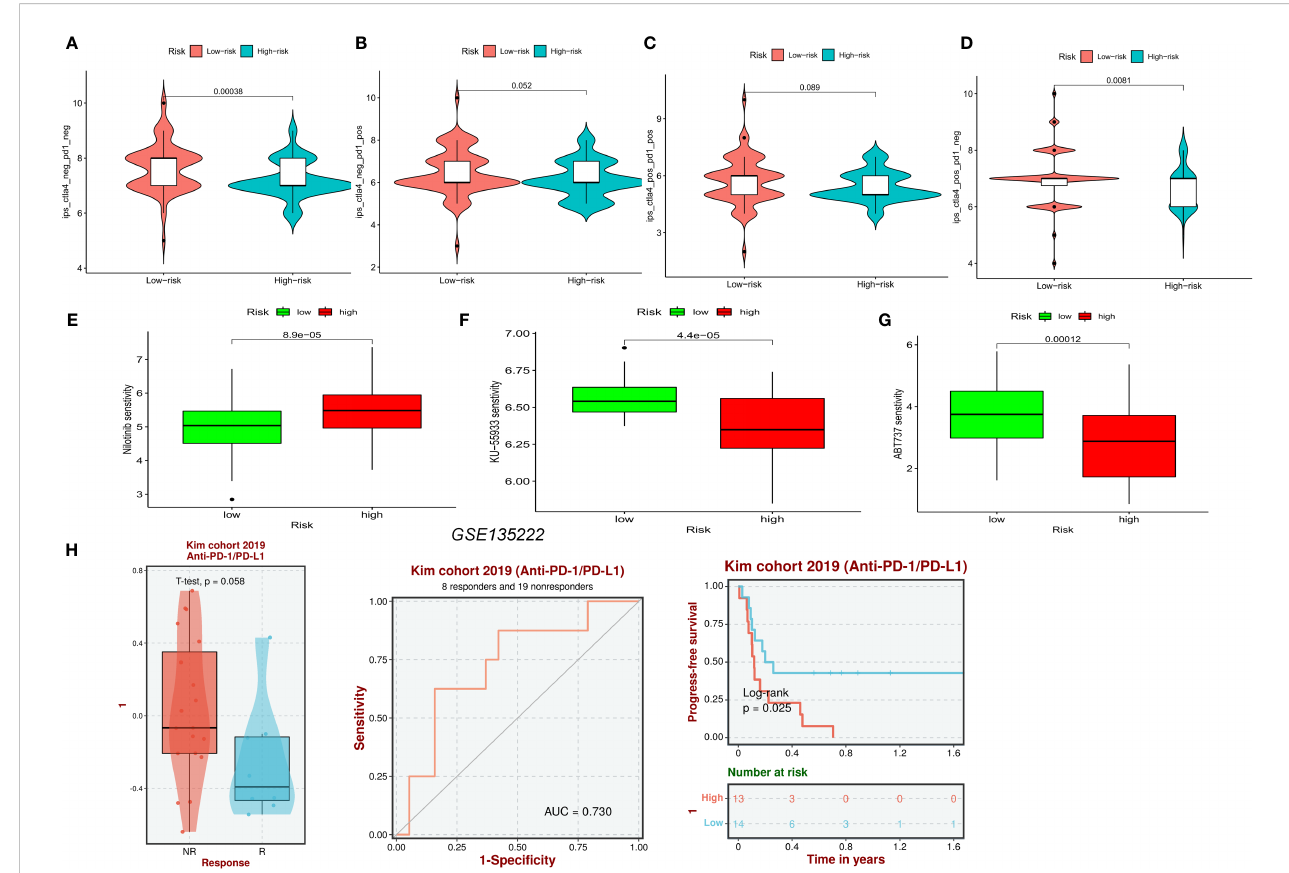
FIGURE 10 Prediction of pharmaceutical and immunotherapy for various risk groupings. (A – D) The comparison of the relative distribution of immunophenoscore (IPS) between high and low-risk groups. (E – G) IC50 values for patients in the high- and low-risk groups based on Nilotinib, ABT737, and KU-55933 to assess the sensitivity of chemotherapeutic agents. (H) Evaluation of anti-PD-L1 therapy in the GSE135222 cohort by